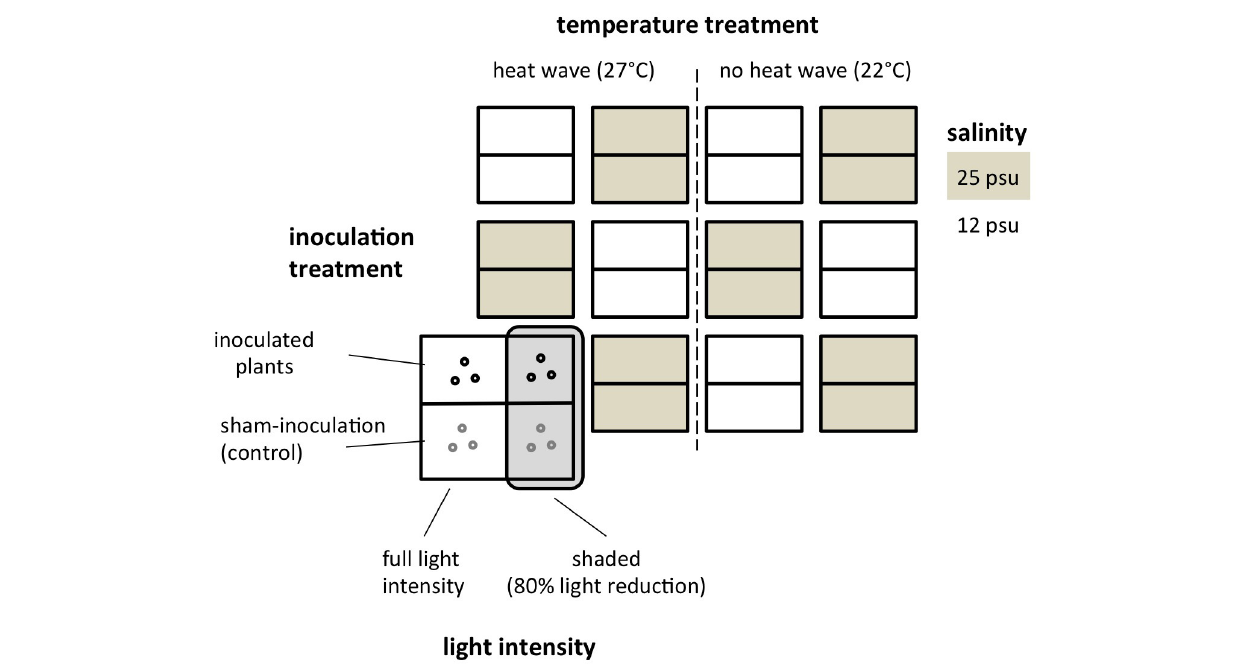
FIGURE 1 | Experimental design of the eelgrass- Labyrinthula multi-stressor experiment. Depicted is the distribution of tanks and experimental units, and the corresponding temperature, salinity, light and L. zosterae inoculation treatment. Treatments were randomized in space with respect to the temperature treatments.